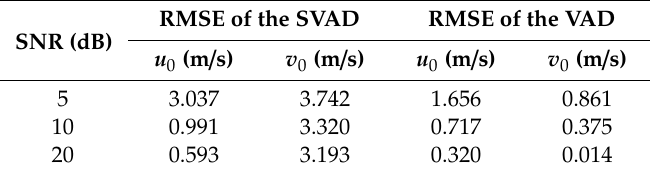
Table 5. Performance comparison between the spaceborne version of the velocity–azimuth display (SVAD) and VAD, for uniform wind field. RMSE of the SVAD RMSE of the VAD SNR (dB) u 0 (m / s) v 0 (m / s) u 0 (m / s) v 0 (m / s) 5 0.879